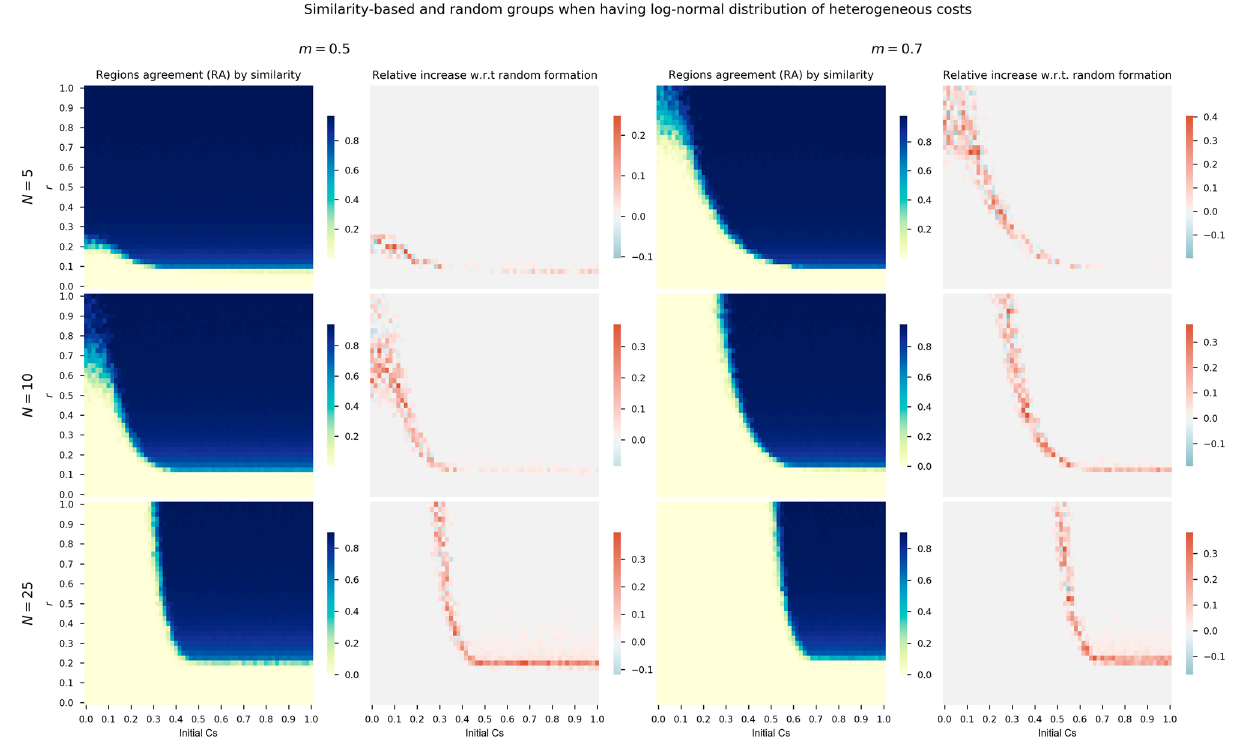
show relative RA differences when using log-normal distribution costs and grouping by similarity with respect to random